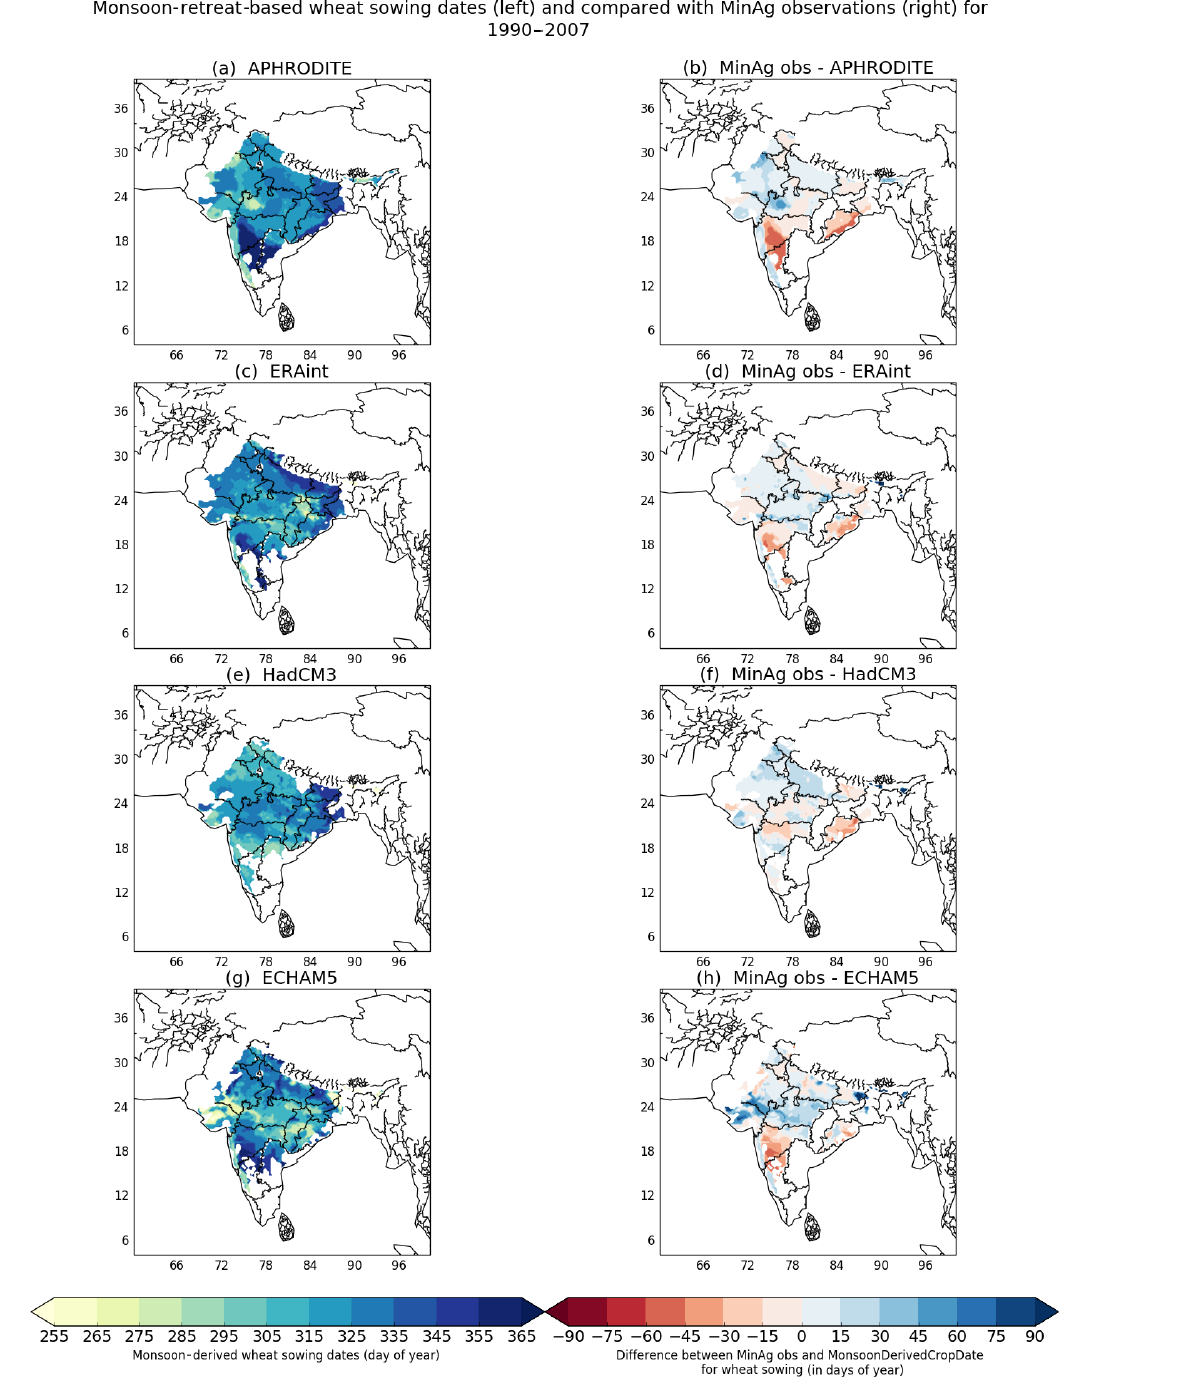
Figure C2. The monsoon-derived wheat sowing dates (a, c, e, g) and the difference between the MinAg observations and the monsoon- derived wheat sowing dates (b, d, f, h) for the period